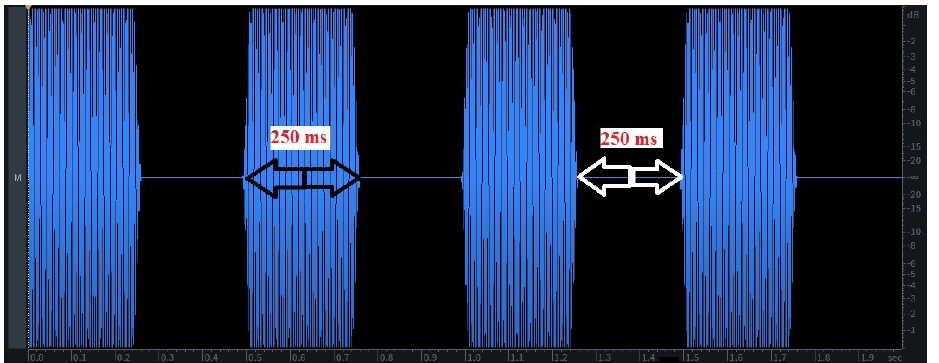
Figure 1. Example of a 2-s test signal pattern that has 250 ms of sinusoidal bursts of a given frequency followed by 250 ms of